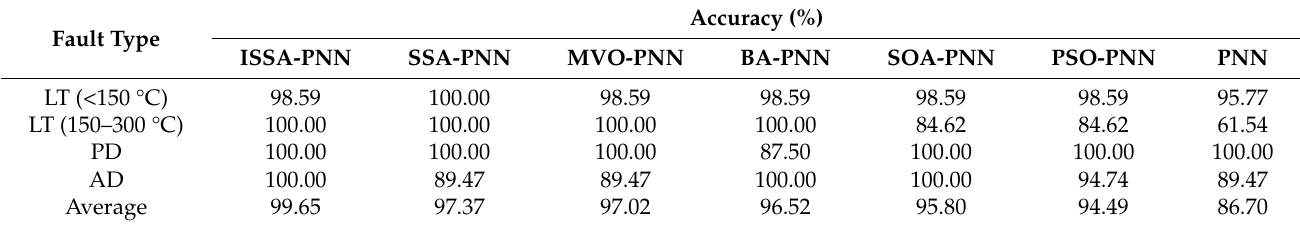
Table 6. Accuracy comparison of different optimized PNN methods.